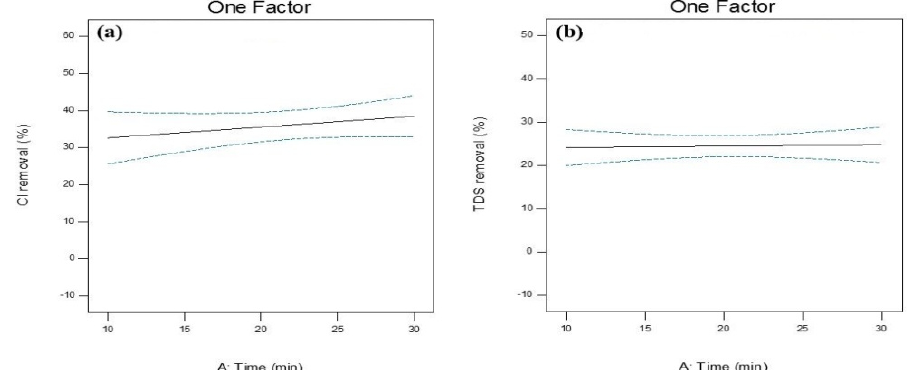
Fig. 8. Plots for effects of a time factor on a) Cl − ion removal rate (%) (Consumption Voltage: 9 V; Cl − Ion initial concentration: 412 ppm) and b) TDS removal rate (%) (Consumption Voltage: 9 V; Cl − ion initial concentration: 412 ppm